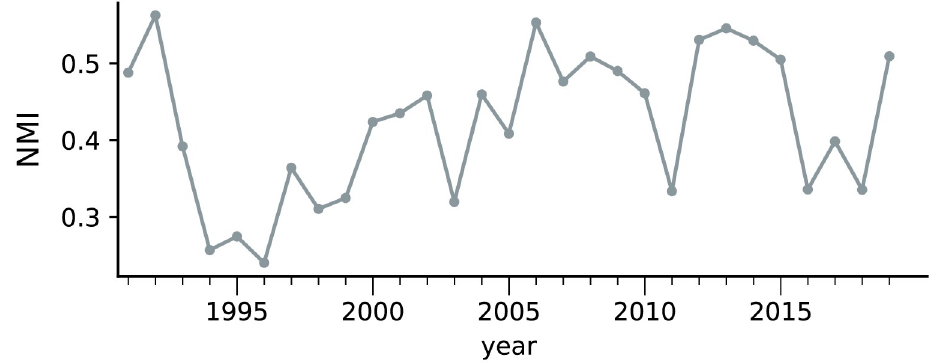
Fig 8. Normalized Mutual Information (NMI) between communities and political parties. A major transition affecting the NMI occurred just before the first PSDB presidency, from 1993 to 1994.